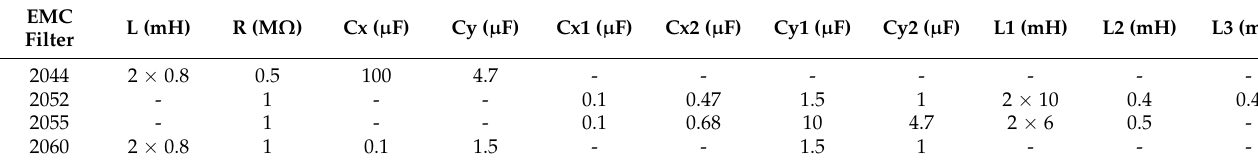
Table 2. Components of the four EMC filters [16].